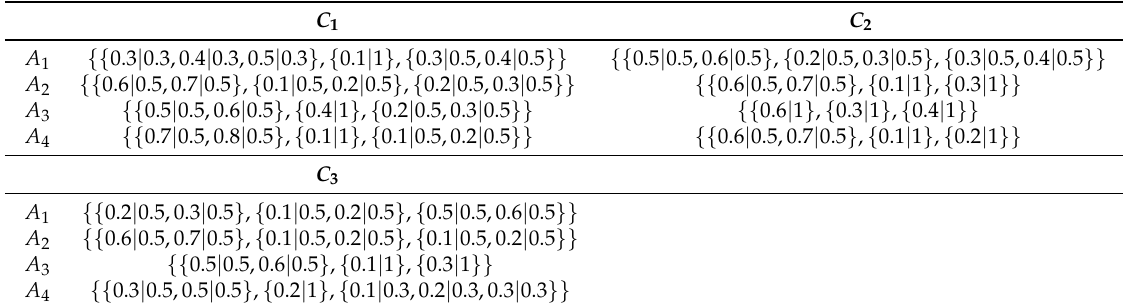
Table 1. Probabilistic neutrosophic hesitant fuzzy decision matrix of the investment problem. C 1 C 2 A 1